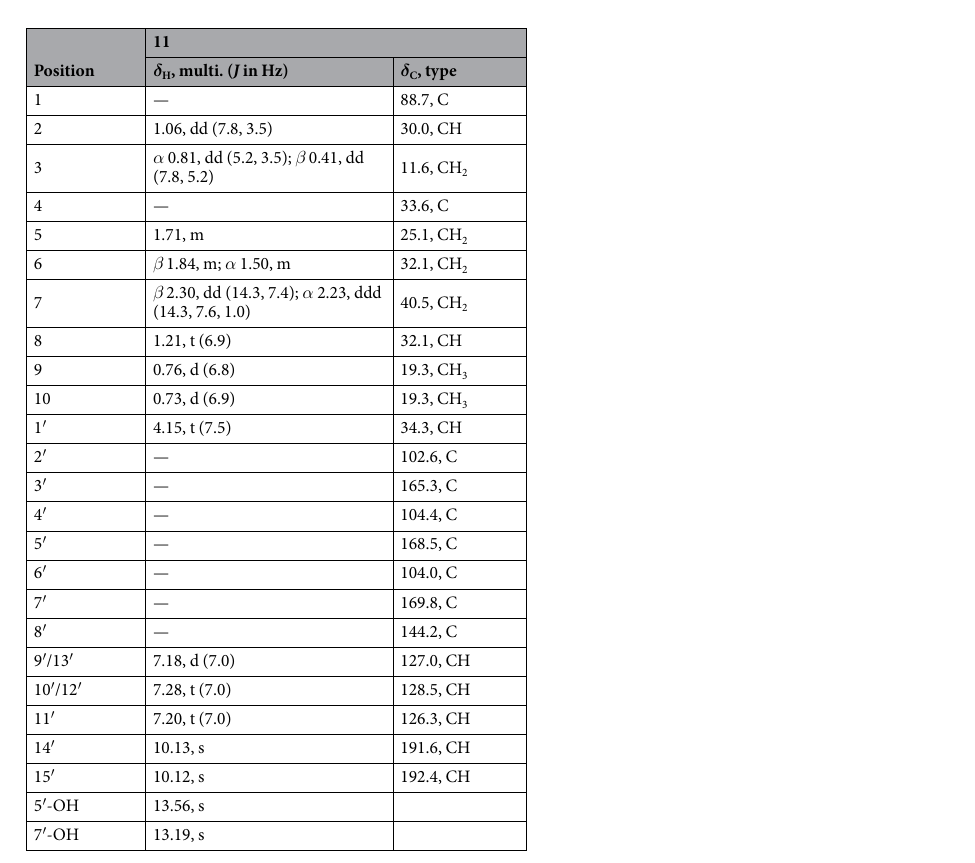
Table 5. 1 H (400 Hz) and 13 C NMR (100 Hz) data of compound 11 in CDCl 3 ( δ in